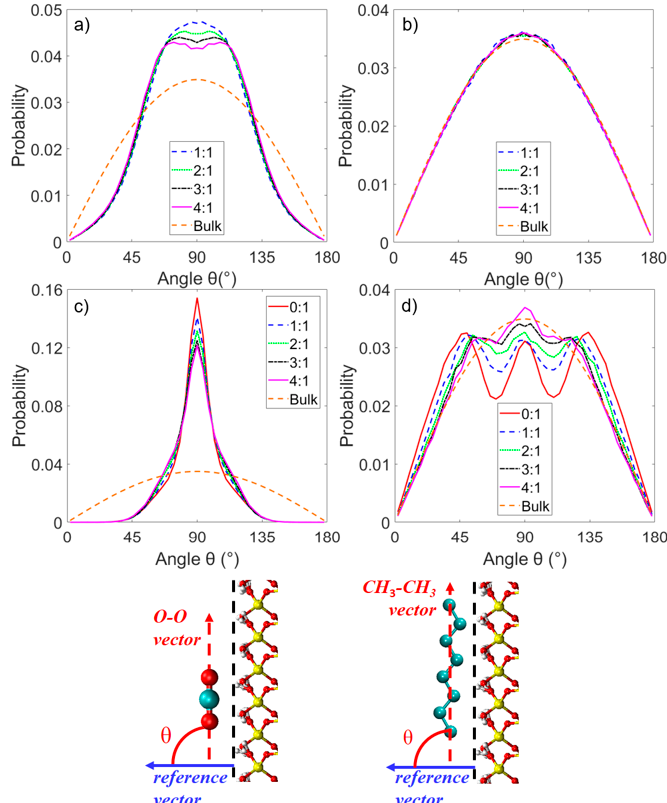
Figure 8. The orientation distribution of ( a ) CO 2 in first adsorbed layer, ( b ) CO 2 in second adsorbed layer, ( c ) n -octane in first adsorbed layer, ( d ) n -octane in second adsorbed layer. The orange dash line is the orientation distribution in bulk state. The angle definition of CO 2 (O–O vector) and n -octane (CH 3 –CH 3 vector) are shown at the bottom.